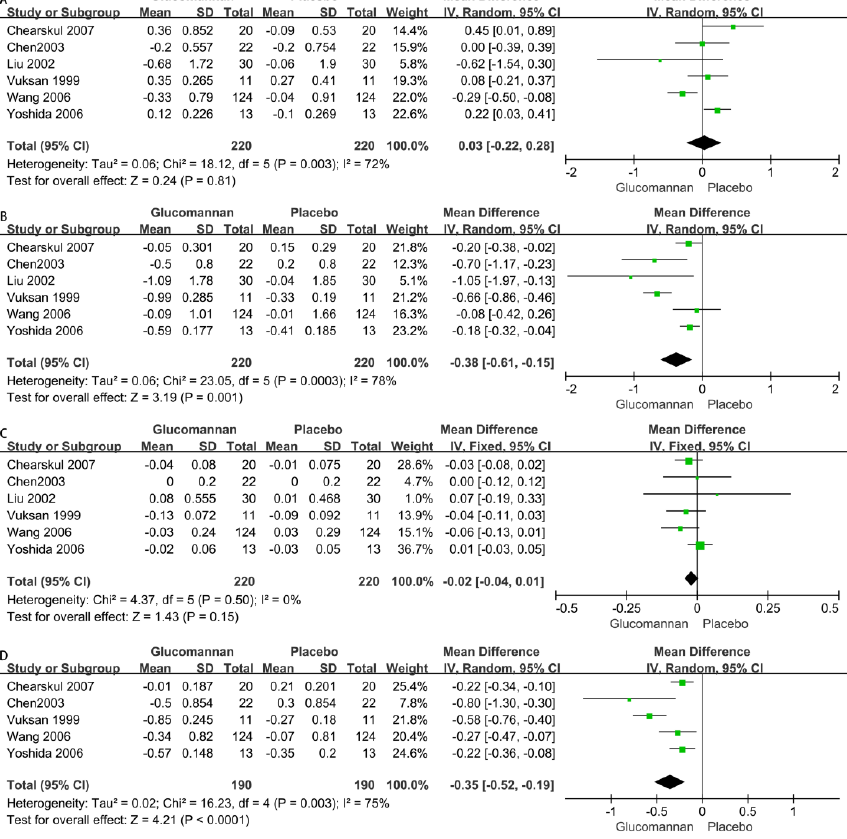
Figure 4. Forest plot of studies [20–25] on the effect of glucomannan intake on blood lipids included in this analysis. Effects of glucomannan on the TG ( A ), TC ( B ), HDL ( C ), and LDL ( D ) were analyzed, where green boxes indicate the odds ratio of the original research data and black diamonds indicate the overall odds ratio of studies included.